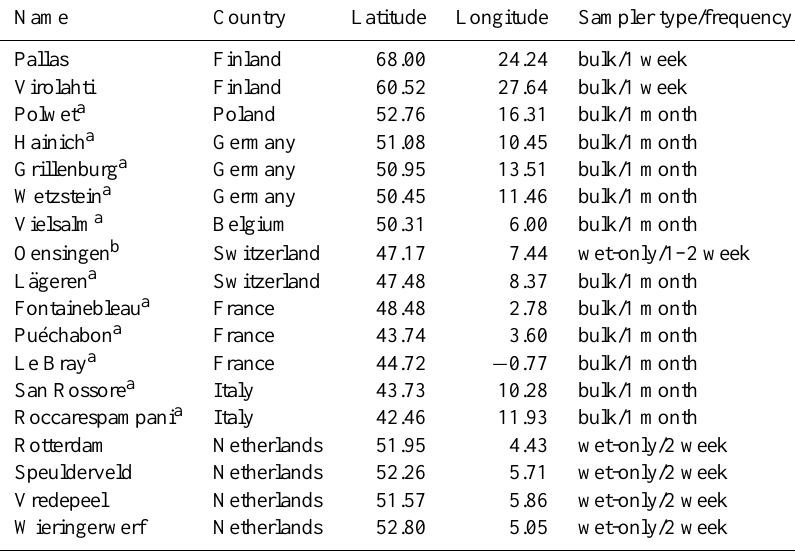
Table 1. List of sites with locations; those in the NitroEurope Level 1 network (Flechard et al., 2011) are shown by a , and in the NitroEurope